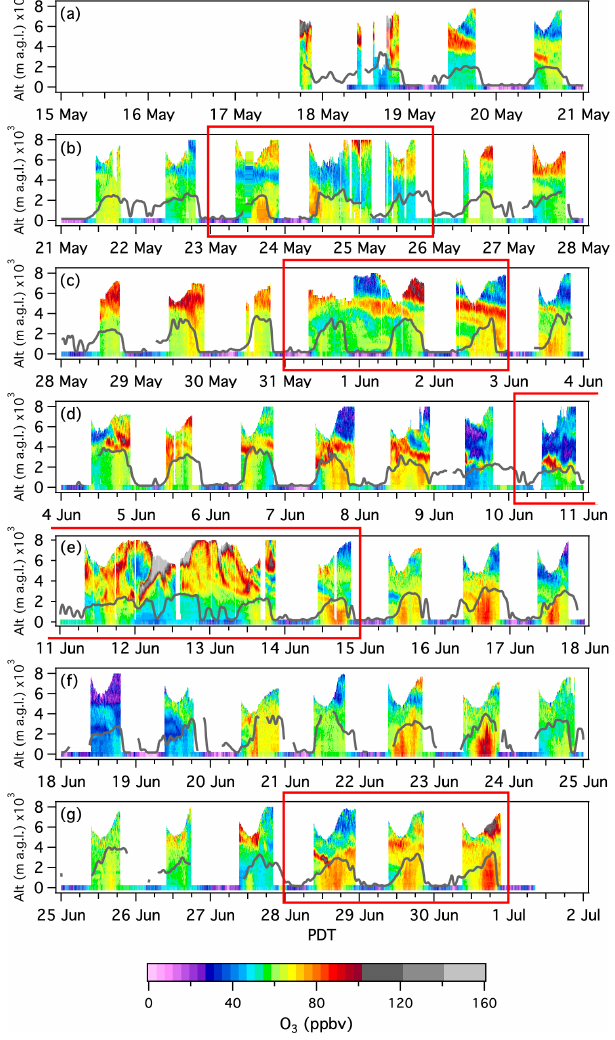
Figure 4. Time–height curtain plots showing the TOPAZ ozone measurements from the NLVA. The axes are altitude (Alt) above ground level and Pacific Daylight Time (PDT). The continuous rib- bon along the bottom shows the measurements from the in situ sur- face monitor in the TOPAZ truck, and the dark-gray curves show the boundary layer heights inferred from the co-located Doppler lidar measurements. The red boxes bracket the four